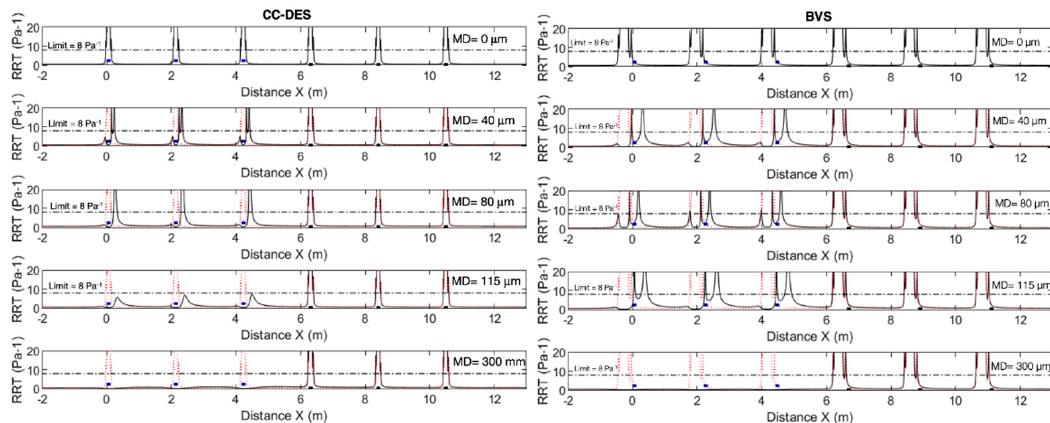
Figure 6. Relative residence time (RRT) distribution for the malapposition configuration. For sake of simplicity, only five representative configurations are displayed for each strut size (MD = 0, 40, 80, 115 and 300 µm). Strut locations are indicated with black rectangles. Notice that axial distance = 0 mm corresponds to the location of the first malapposed strut.